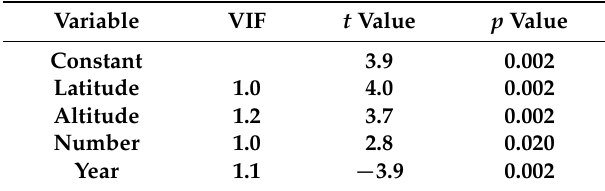
Table 5. Results of the model that best described (delta AICc <2 based) the relationship between the L. duplicati infection level in I. duplicatus populations (arcsine square root transformed). The best model included four predictor variables: latitude (north-south gradient); altitude; number of I. duplicatus beetles captured and dissected; year (date of beetle collection). Variance inflation factor (VIF). Corrected Akaike’s Information Criterion (AICc) = − 25.95 (significant variables are in